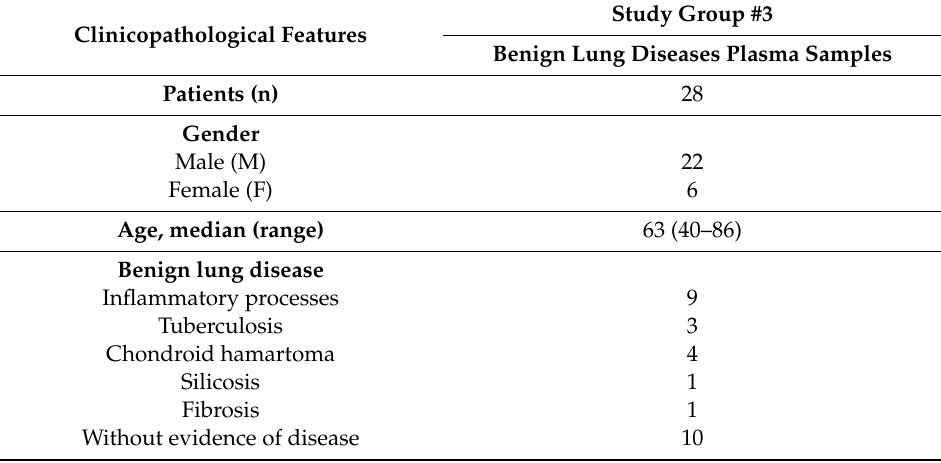
Table 2. Clinicopathological features of benign lung disease patients from study group